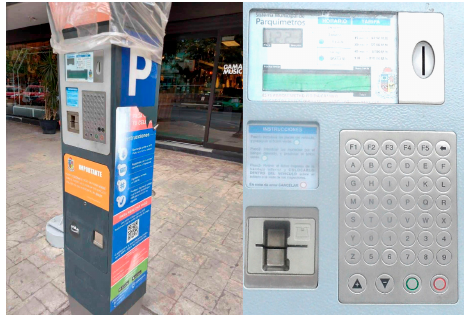
Figure 4. Overview and closeup of the CFE-Mático ATM interface located in Monterrey and Mexico City, Mexico.